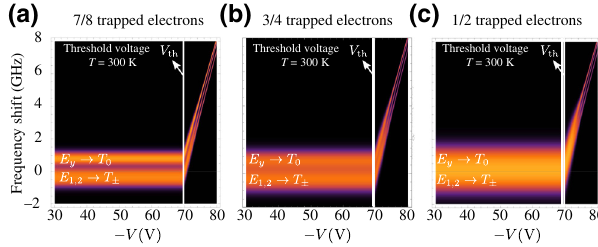
FIG. 10. Single (kk) divacancy photoluminescence with (cid:22) (cid:22) (cid:23) (cid:23) (cid:22) (cid:22) (cid:2) and (cid:2) addressed transitions for (a) 7/8, → | T → | T E 1,2 E y ± 0 (b) 3/4, and (c) 1/2 fractions of trapped